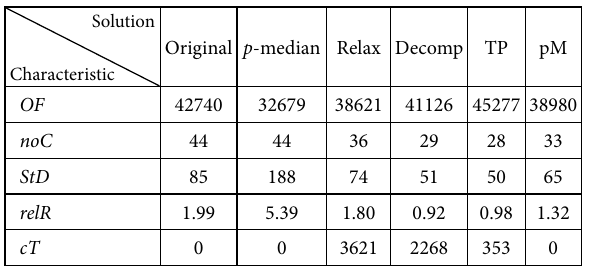
Table 10. Comparison of the results for the region KE